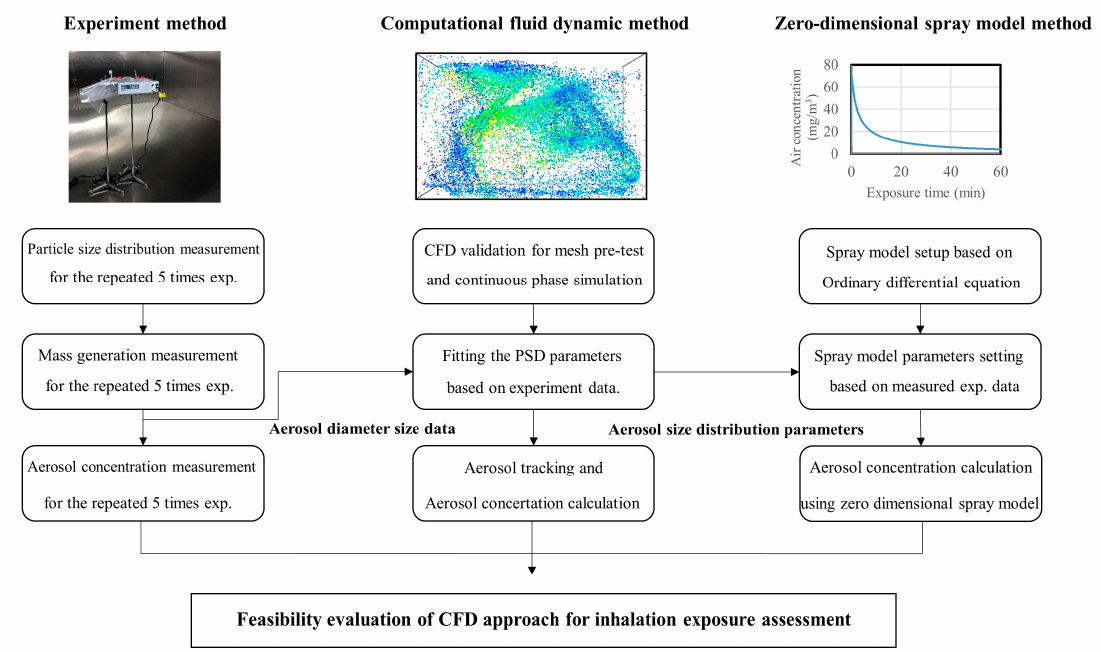
Figure 1. Research flow chart. The CFD and PSD mean computational fluid dynamics and particle size distribution, re ‐ spectively.